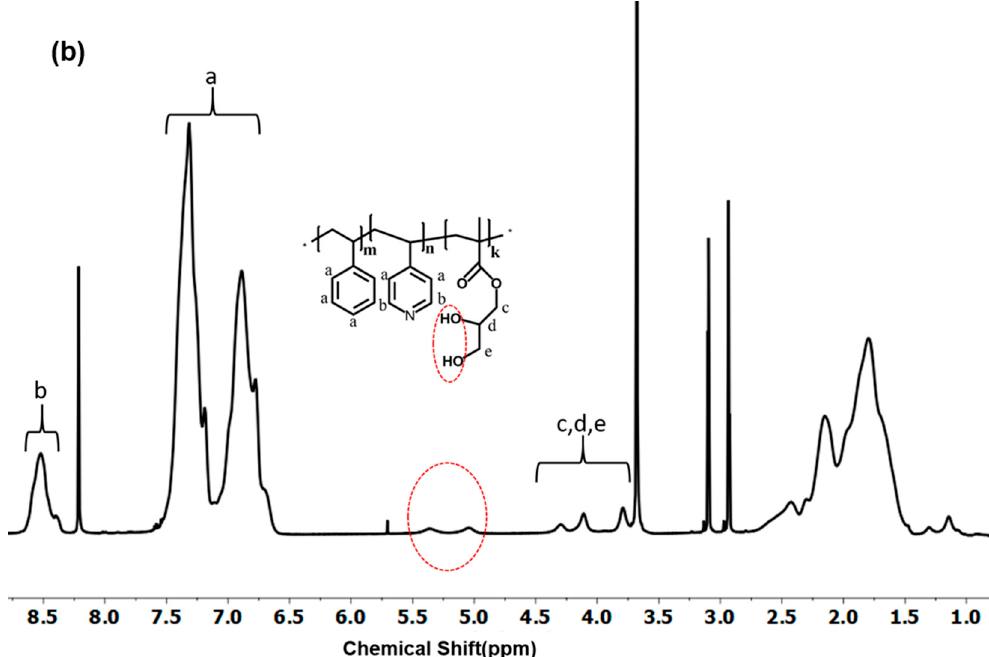
Figure 6. 1 H-NMR spectrum (in CDCl 3 ) of the linear triblock terpolymer re-dissolved membranes ( a ) PS 71 - b -P4VP 26 - b -PSMA 3145 before and ( b ) after hydrolysis in DMF- d 7.